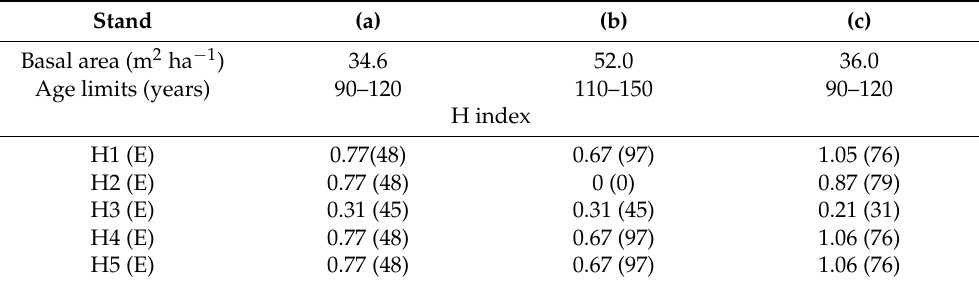
Figure 7. Structure of ( a ) mixed sessile oak–beech stands, ( b ) beech stands, and ( c ) mixed beech–fir stands. See Table 5 for the characteristics used. Table 5. Characteristics used in Figure 7.